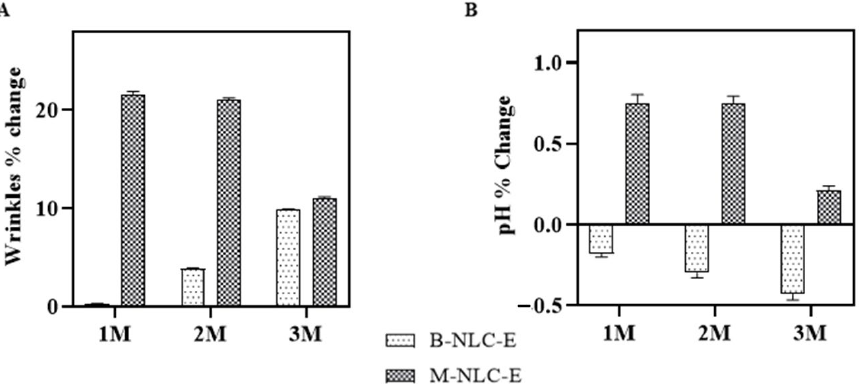
Figure 15. Wrinkles ( A ) and skin pH ( B ) analysis after 1st (M1), 2nd (M2) and 3rd month (M3) of use of B-NLC-E and M-NLC-E.